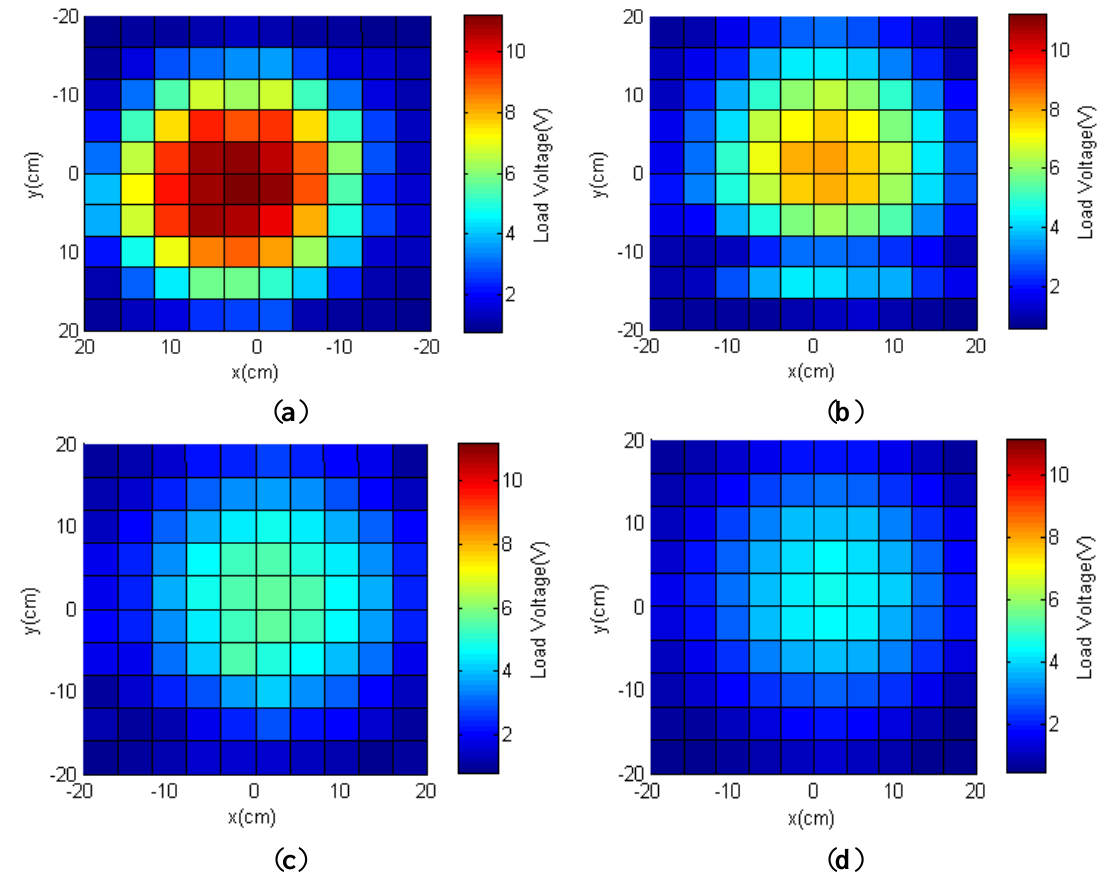
Figure 6. Measured load voltages at different distances z of ( a ) 4; ( b ) 7; ( c ) 10 and ( d ) 11 cm when a load of 745 Ω was connected to the receiver